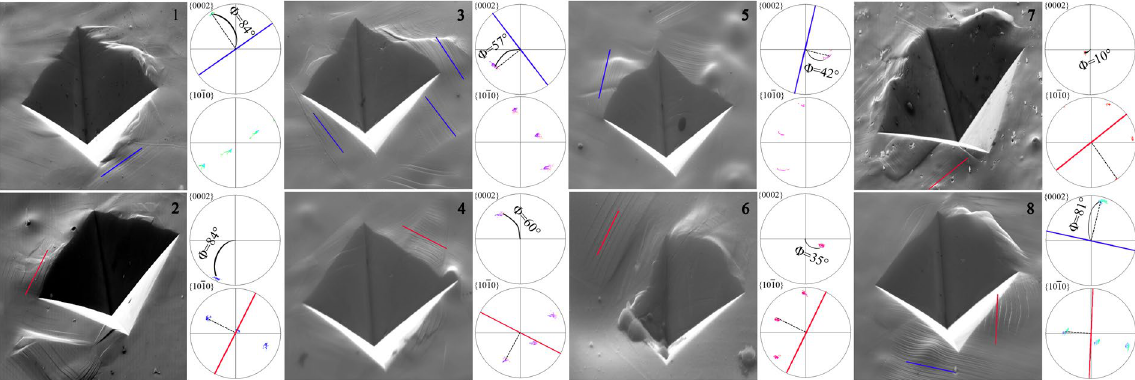
Figure 6. Slip trace analysis illustrating the activated slips during Vickers hardness test. The lines on the pole figures correspond to the trace of the slip plane closest to the observed slip trace (basal slip trace - blue line, prismatic slip trace - red line). Φ is the angle of basal pole away from the